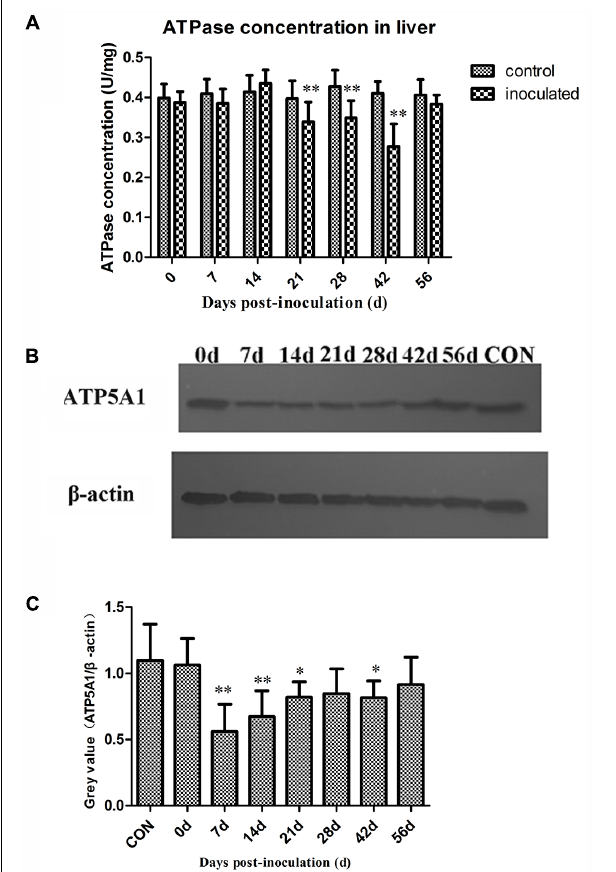
FIGURE 3 | Changes in activity of ATPase and ATP sythetase ATP5A1. (A) The activity ATPase in hepatocyte decreased significantly in inoculated group compared with the control group at 21, 28, and 42 dpi ( p < 0.01), ∗ p < 0.05, ∗∗ p < 0.01. (B) Western-blot analysis of ATP5A1 in hepatocyte of control group and inoculated group gerbils. (C) A semi-quantitative analysis of relative expression of ATP5A1/ β -actin.